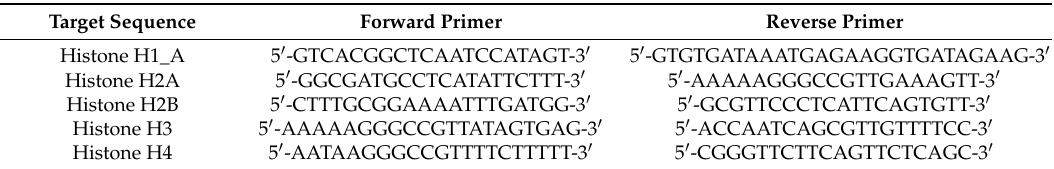
Table 1. Primers used for the amplification of histone-like sequences from Lucina pectinata RNA by